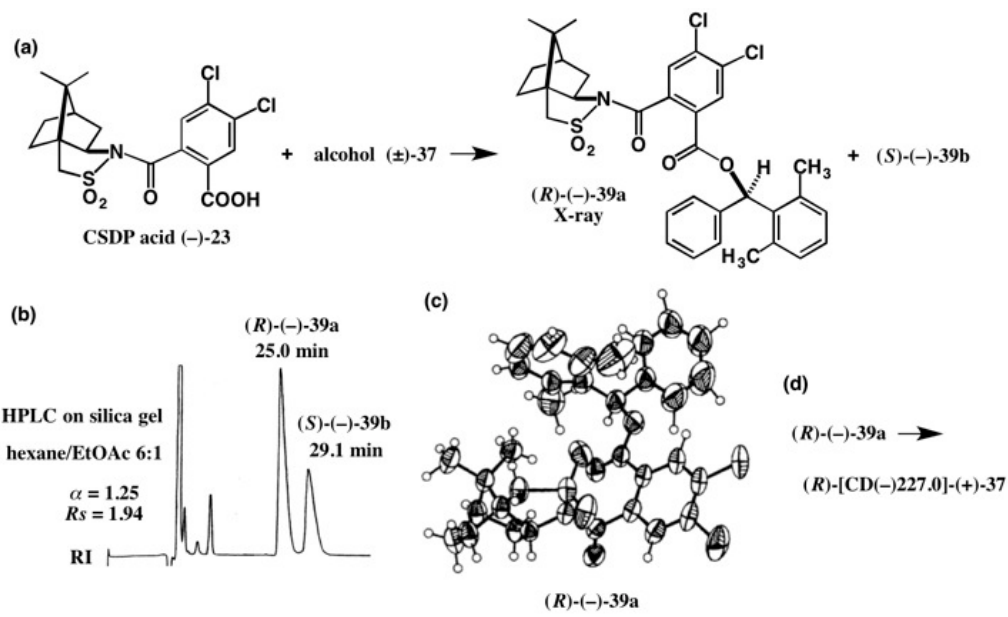
Figure 25. Preparation ( a ) and HPLC separation ( b ) of esters 39a and 39b , and the AC determination of ester ( R )-( − )- 39a by X-ray crystallography ( c ). Alcohol ( R )-[CD( − )227.0]-(+)- 37 was recovered from ester ( R )-( − )- 39a ( d ). HPLC, redrawn from [44]. ORTEP drawing, reprinted from [43].